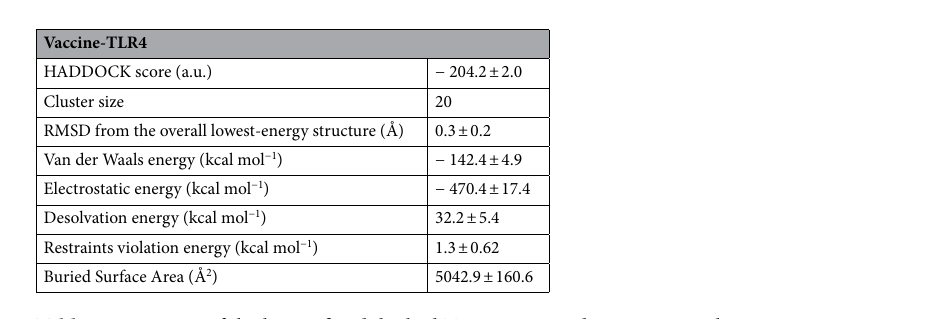
Table 6. Statistics of the best refined docked TLR4/MD2 and vaccine complex. Strong protein interaction expressed in arbitrary units (a.u.) is represented by smallest HADDOCK score.